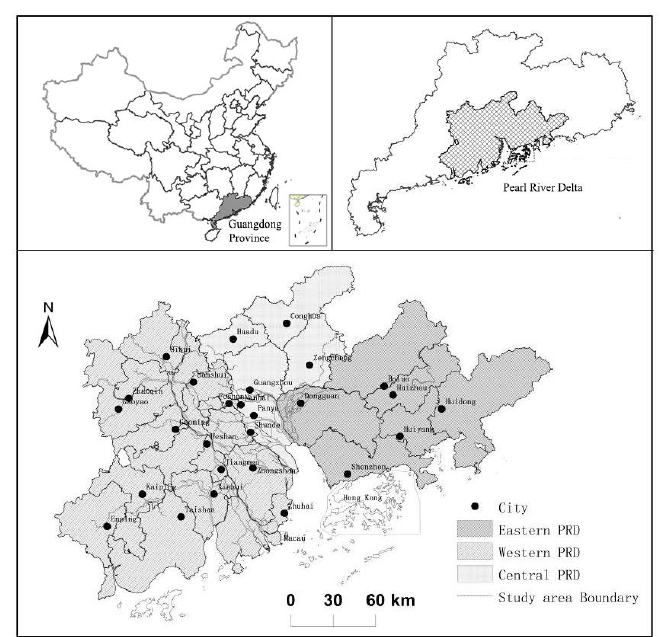
Figure 1: The study area - Pearl River Delta